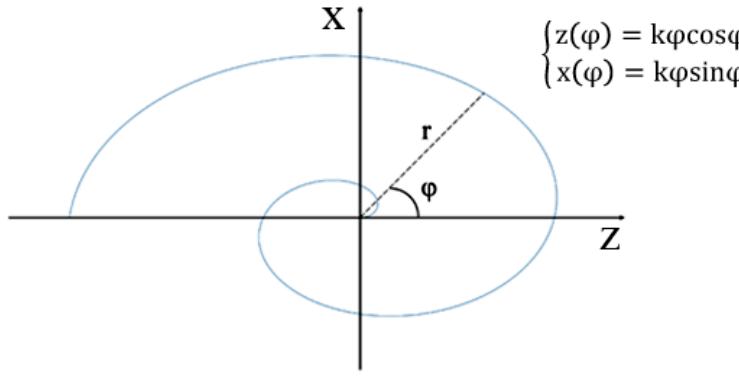
Figure 1. Archimedean spiral (not to scale) function with the set of parametric equations.